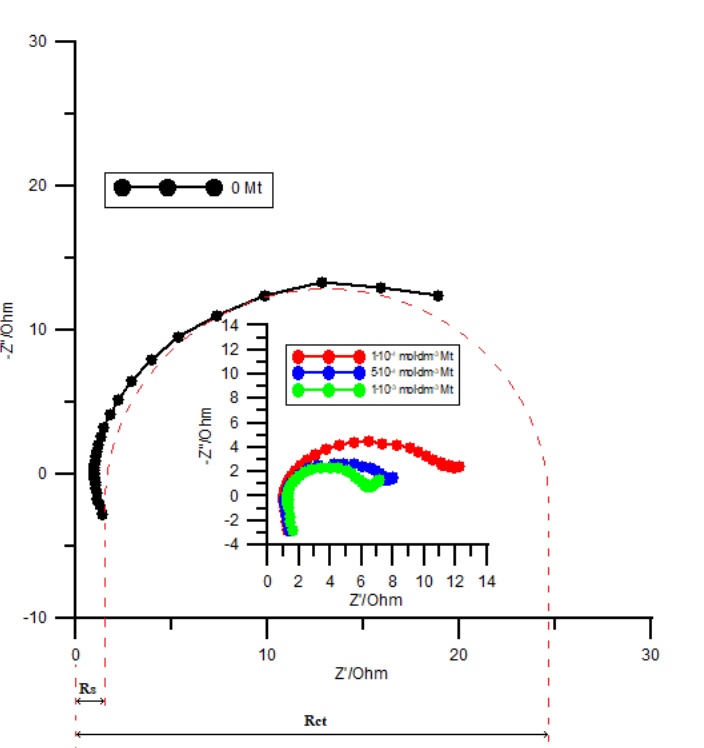
Figure 8. Impedance diagrams measured at E f0 for the electroreduction of 1 × 10 −3 mol dm −3 Bi(III) in 1 mol dm −3 chlorate(VII) solution in the presence of methionine. The values for the concentration of methionine are given in the plot.